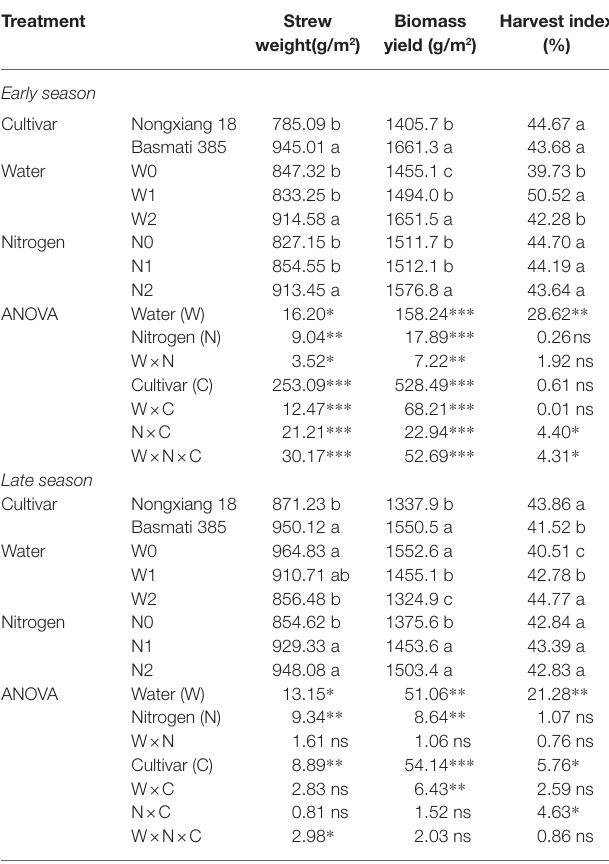
TABLE 4 | Straw weight, biomass yield, and harvest index as affected by water, nitrogen, and cultivar in the early and late seasons of double rice cropping system in South